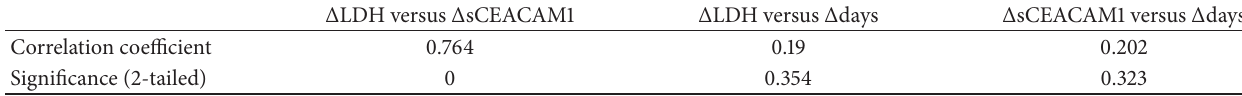
Table 1: The correlations between Δ sCEACAM1, Δ LDH, and Δ days in melanoma